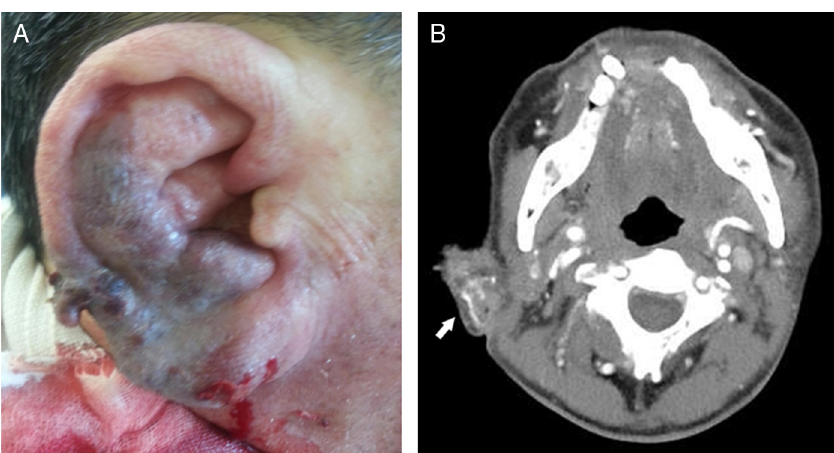
Figure 1 Gross findings and temporal bone computed tomographic angiography findings on the ear of a 60 year-old man, as recorded in the emergency room: (A) the patient presented with a swollen ear and spontaneous massive bleeding; (B) temporal bone computed tomographic angiography revealed a right-side, auricular vascular tangled lesion (white arrow).